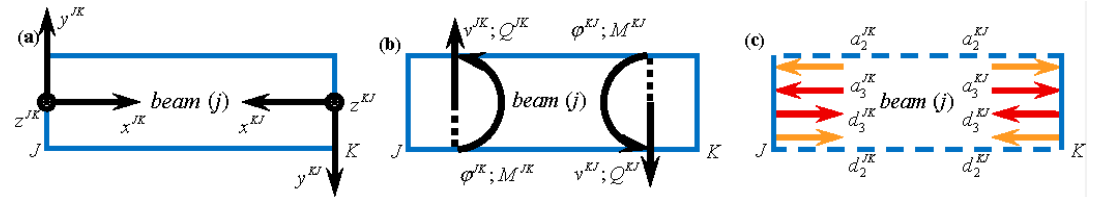
Figure 3. The description of a typical structural member ( j ) : ( a ) The dual local coordinates; ( b ) The generalized displacements and forces; ( c ) The wave amplitudes.